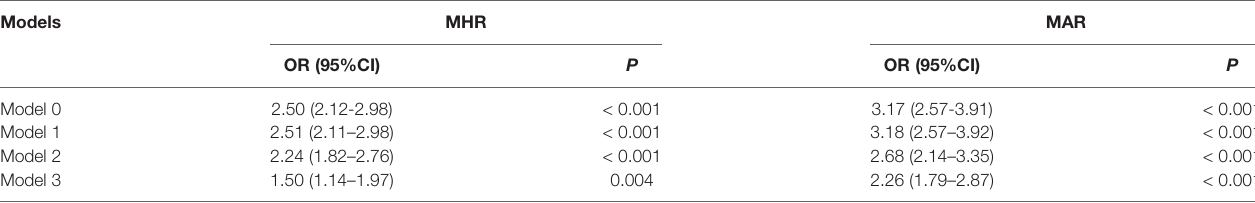
TABLE 5 | Binomial Logistic Regression Analysis adjusted ORs (95% CIs) for the associations between MHR, MAR and the risk of MetS. Models